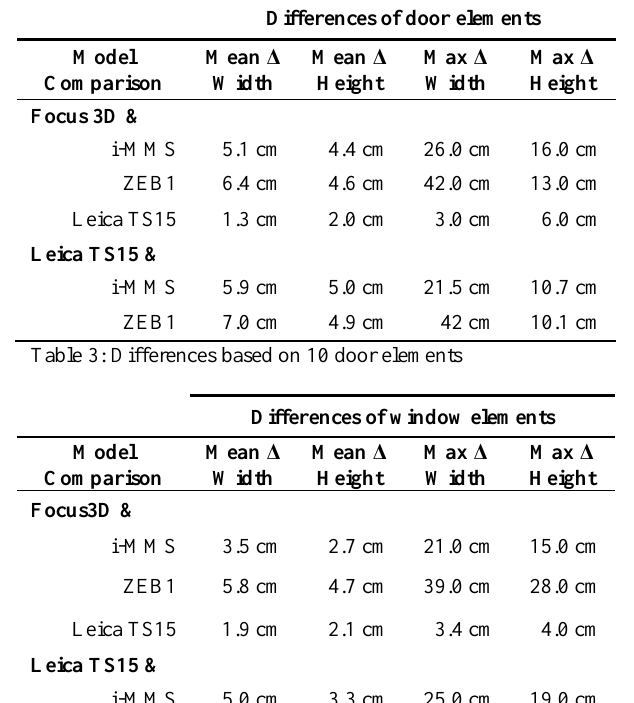
Figure 7: Detail of the point clouds and the model (top row solid lines) for the systems; in the same sequence as